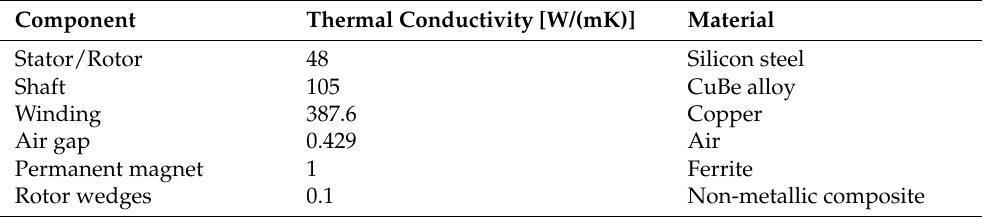
Table 6. Thermal conductivity of the components used in the simulation. Data from [19,22,23].